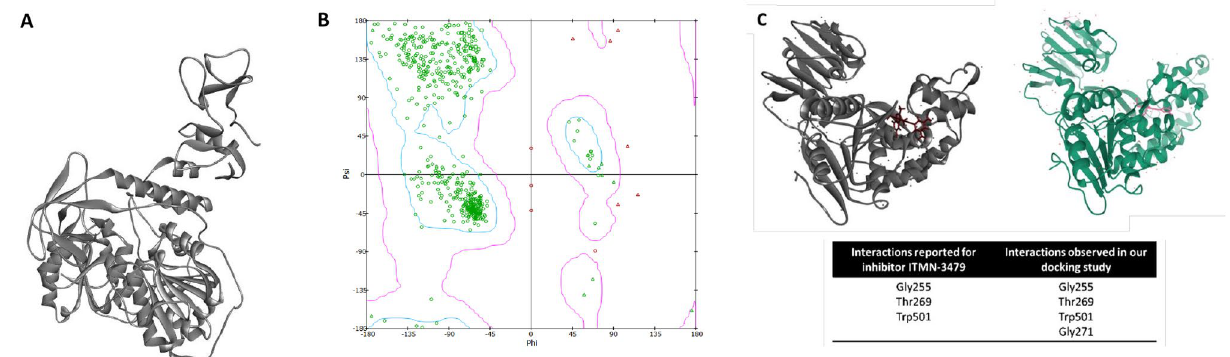
Figure 2. Validation of structure and docking strategy: ( A ) Structure of SARS-CoV-2 helicase used in the study, ( B ) Ramachandran plots for SARS-CoV-2 helicase structure (PDB ID: 5RL6) used in the study, and ( C ) Docking strategy was validated by re-docking a previously published inhibitor ITMN-3479 on its receptor. Poses of ligand bound to the receptor generated after docking in our study (left, ligand, and protein are shown in red and dark grey, respectively) and retrieved from PDB (right; ligand and protein are shown in pink and green, respectively) are shown, while the bottom panel shows amino acid interactions reported for each ligand and observed in our